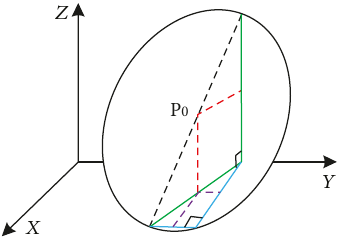
Figure 8: Determination of the location of the SMA